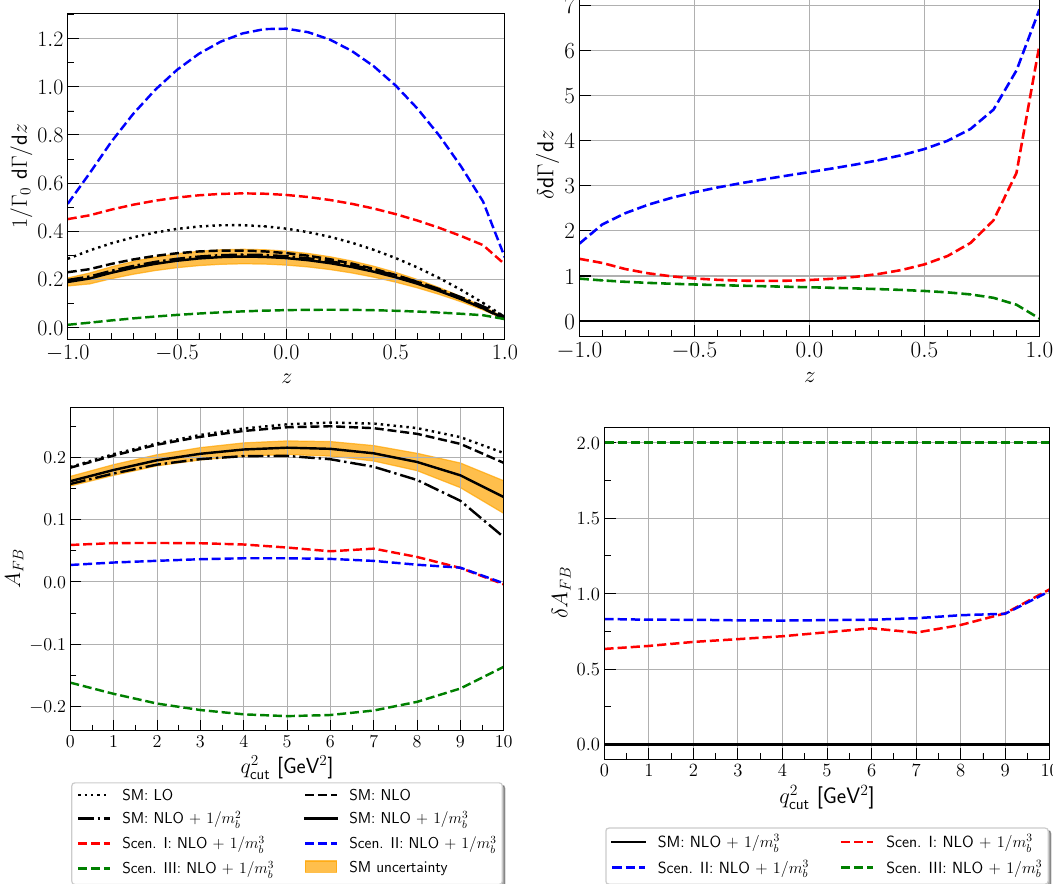
Figure 7. (Upper part) The differential rate for B → X c ‘ ¯ ν ‘ as a function of z without lepton energy cut and relative size of the NP scenarios w.r.t. the SM prediction. (Lower part) Forward- backward asymmetry as a function of the q 2 cut for the three NP scenarios in table 2 and their relative size w.r.t. the